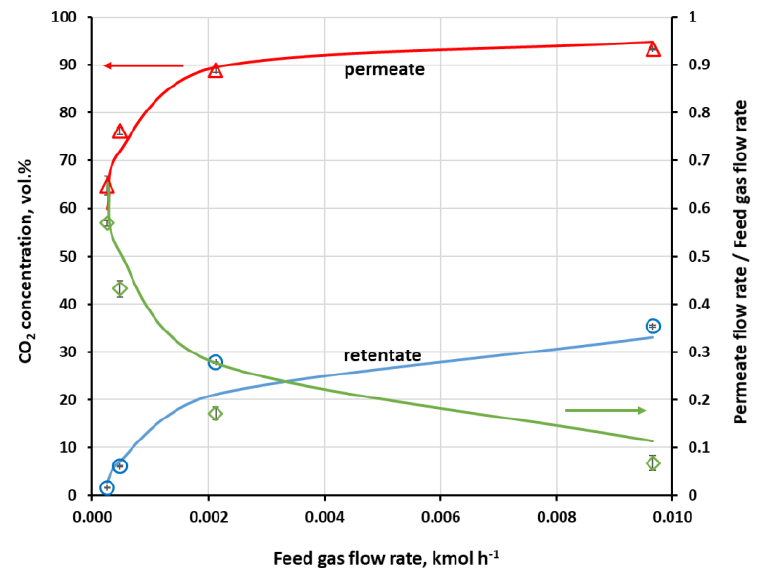
Figure 5. Experimental (points) and theoretical (lines) CO 2 concentration in the retentate and permeate along with flux cut ratio against feed gas flow rate in UBE UMS-A5 module. Feed gas pressure: 0.4 MPa (a); composition of feed gas: CH 4 (60 vol.%)/CO 2 (40 vol.%); temperature: 295 K.